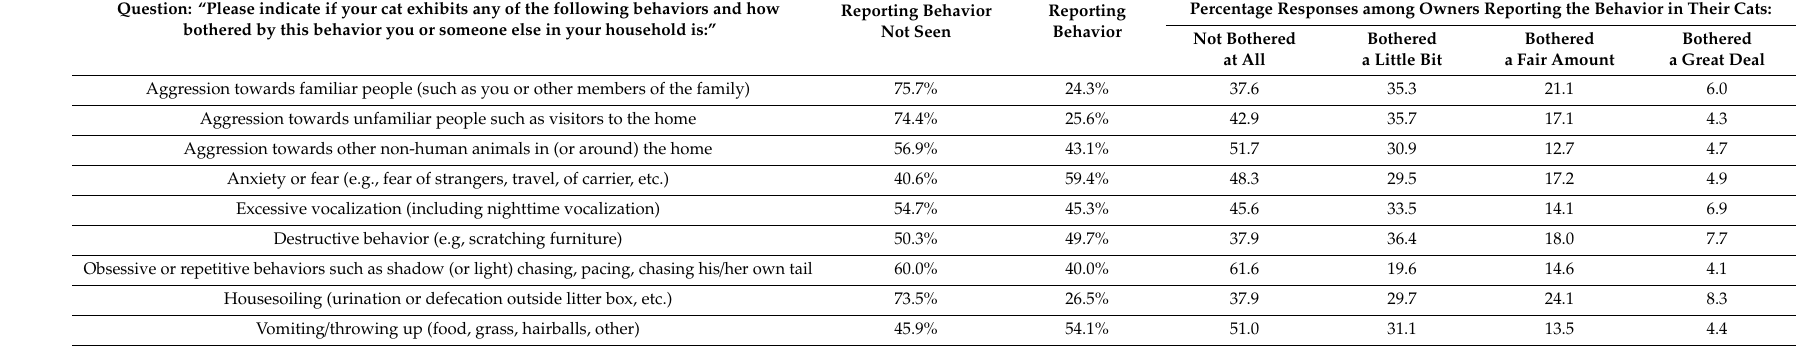
Table 3. Prevalence of surveyed potential feline behavior problems, and (for owners encountering these issues) the degree to which the behavior bothered the cat